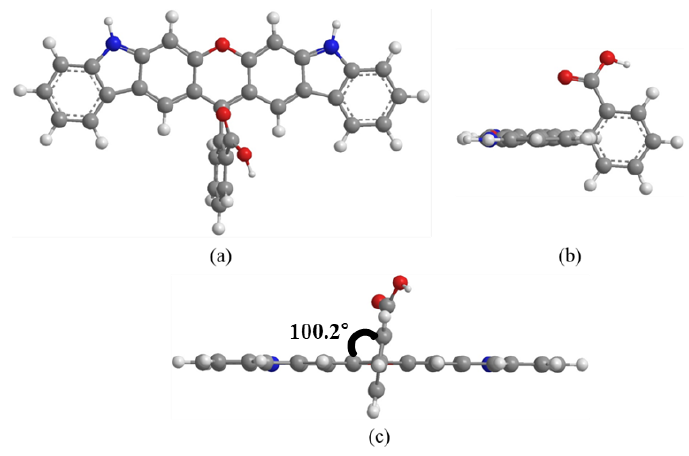
Figure 2. Geometry-optimized structure of the synthesized dye: ( a ) Front; ( b ) Side; ( c ) Top.